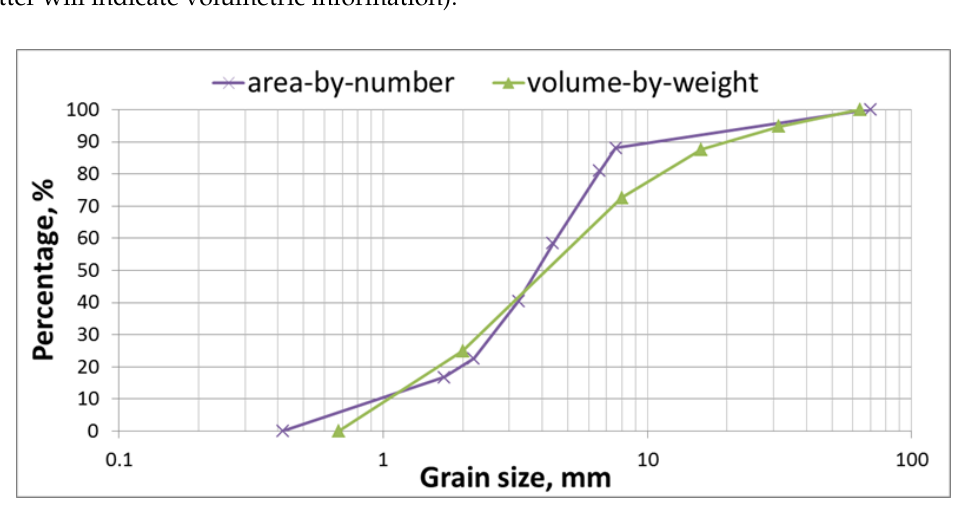
Figure 2. The initial area-by-number (purple) and volume-by-number (green) grain-size distribution of the bed material.